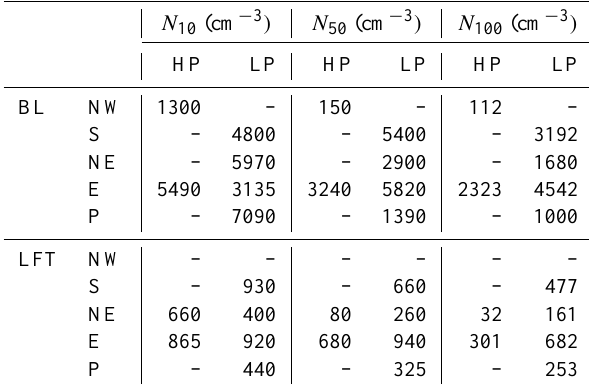
Table 2. Median number concentration in the boundary layer (BL) and in the lower free troposphere (LFT) during anticyclonic (HP) and cyclonic (LP) conditions for the different air mass sectors (NW: north-west Europe; S: south Europe; NE: north Europe; E: east Eu- rope; P: polar). N 10 : CN concentration for particles larger than 10 nm measured with the CPC3010; N 50 : CN concentration for par- ticles larger than 50 nm measured with the SMPS; and N 100 : CN concentration for particles larger than 100 nm measured with the